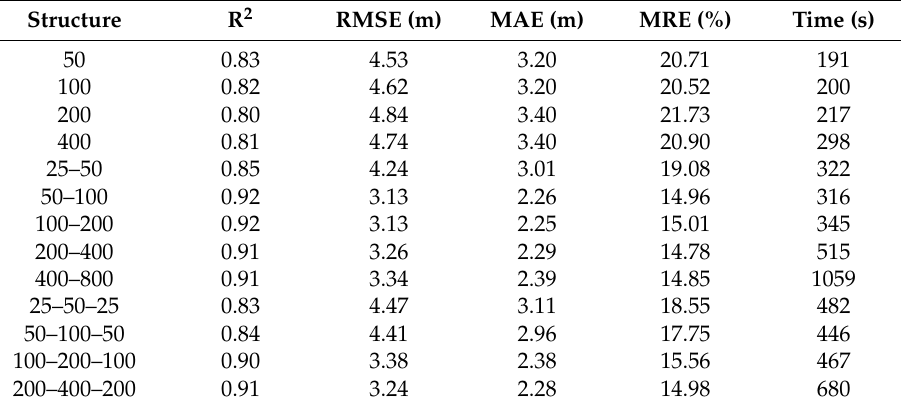
Table 3. Error statistics of di ff erent network